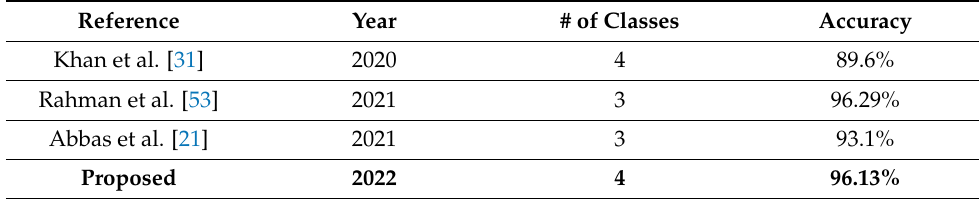
Table 5. Comparison with other